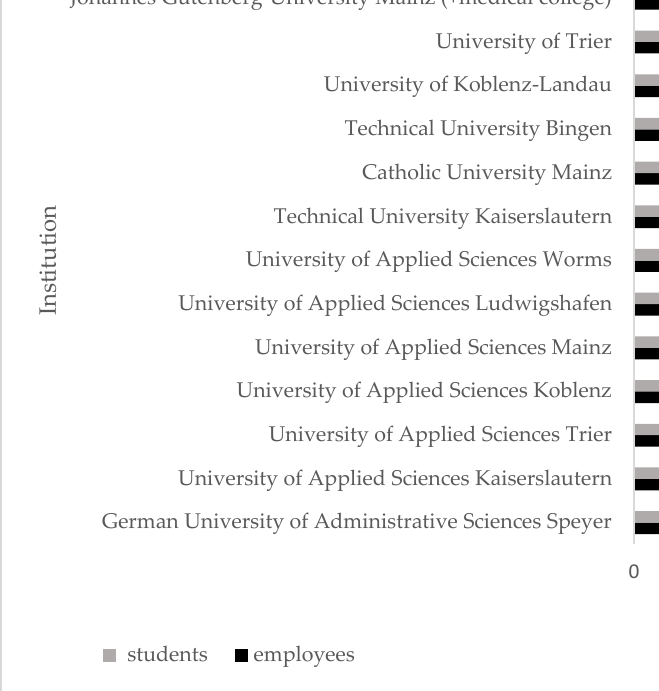
Figure 1. Modified thousand-men quotas (mTMQs) of employees and students from December 2014 to December 2019 for the different institutions. The mTMQ describes the rate of injuries per 1000 employees or 1000 students by adding up the total number of accidents during this period, multi- plying this by 1000, and then dividing the result by the average number of employees or students at the institution during the five-year period.